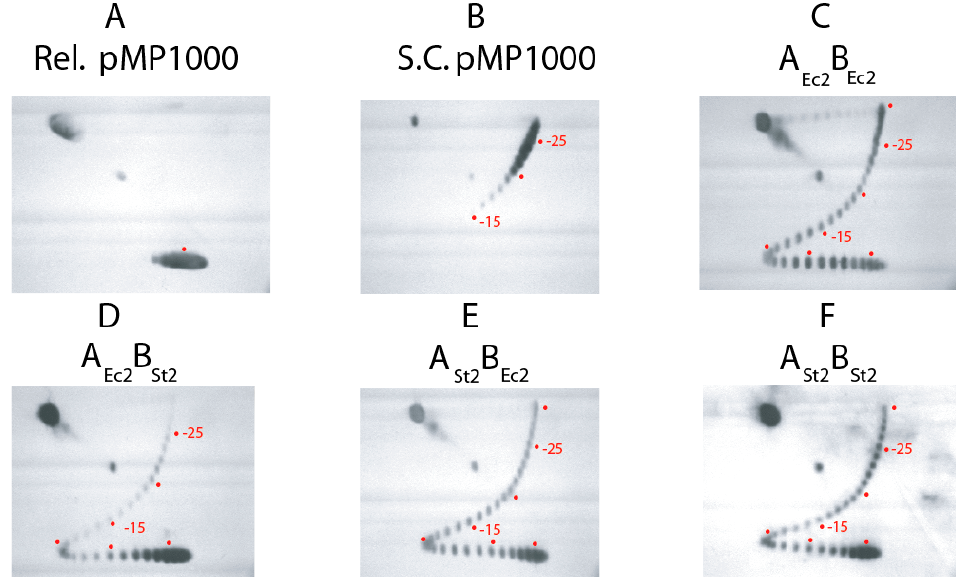
Figure 3. Two-D gel analysis of 5 sec assays for supercoiling of gyrase tetramers reconstituted with native partners and chimeric enzymes reconstituted with mixed S. typhimurium and E. coli subunits. The profile of Top1 relaxed DNA substrate and native supercoiled pMP1000 plasmid are shown in panels ( A and B ) respectively. Panels ( C – F ) show supercoil profiles of 5 s supercoiling reactions carried out with: E. coli gyrase, ( C ); chimera of E. coli GyrA and Salmonella GyrB, ( D ); chimera of Salmonella GyrA and E. coli GyrB, ( E ); Salmonella gyrase, ( F ). The positions of the center of the relaxed substrate is indicated when this band is visible, and positions of bands with − 5, − 10, − 15, − 20 and − 25 supercoils are marked with red dots. Table 1. Doubling times of S. Typhimurium and E. coli strains with different gyrase subunits and chimeric gyrases containing GyrA fusions to whole CTD or 1/2 CDT domains of Salmonella gyrA .